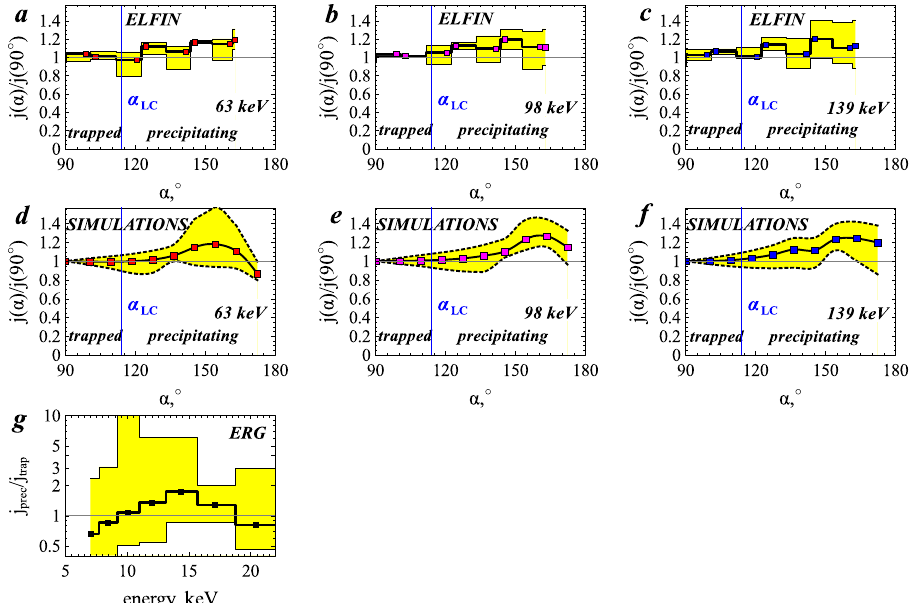
Fig. 5 Comparison of precipitating electron fl uxes (in the loss cone) from observations and from numerical simulations. a – c Local pitch-angle ( α ) spectra of 63, 98, and 139 keV electron fl uxes measured by ELFIN spacecraft, averaged over the most intense precipitation interval (from 03:02:01 to 03:02:14 UT), and normalized to the α = 90° fl ux average, j ( α )/ j (90 ∘ ). d – f j ( α )/ j (90°) from numerical simulations of nonlinear electron Landau resonant interaction with oblique whistler-mode waves measured near the equator by THEMIS-E spacecraft. g Precipitating to trapped electron fl ux ratio j prec / j trap as a function of electron energy measured by Exploration of energization and Radiation in Geospace (ERG/Arase) spacecraft from 02:30:00 to 03:00:00 UT. Yellow regions indicate the highest and lowest fl ux ratios during the averaging interval (note that for ERG, the highest fl ux ratios at 12 – 14 keV have poor counting statistics). Blue vertical lines in the pitch angle spectra indicate the local loss-cone angle, α LC , which separates the trapped and precipitating